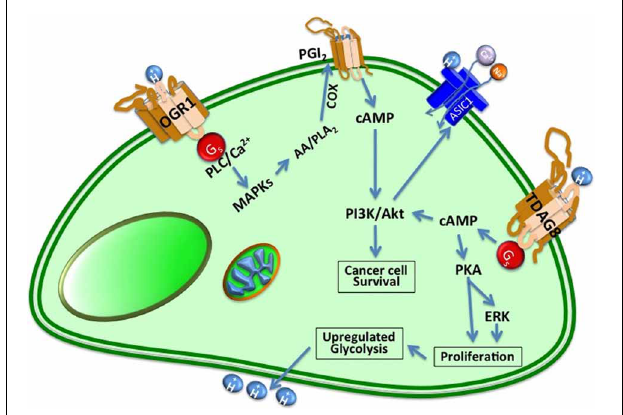
FIGURE 3 | Cancer cells express proton-sensing GPCRs such as GPR4, TDAG8, and OGR1 to regulate their tumorigenesis and invasion. TDAG8 and OGR1 sense extracellular protons, leading to activation of the cAMP signaling pathway. OGR1 is usually coupled with the PLC/Ca 2 + pathway through G q /11 proteins and GPR4 and TDAG8 are coupled with the adenylyl cyclase/cAMP pathway through G s proteins in the cells to PKA and ERK signaling pathway that play pivotal roles in cancer